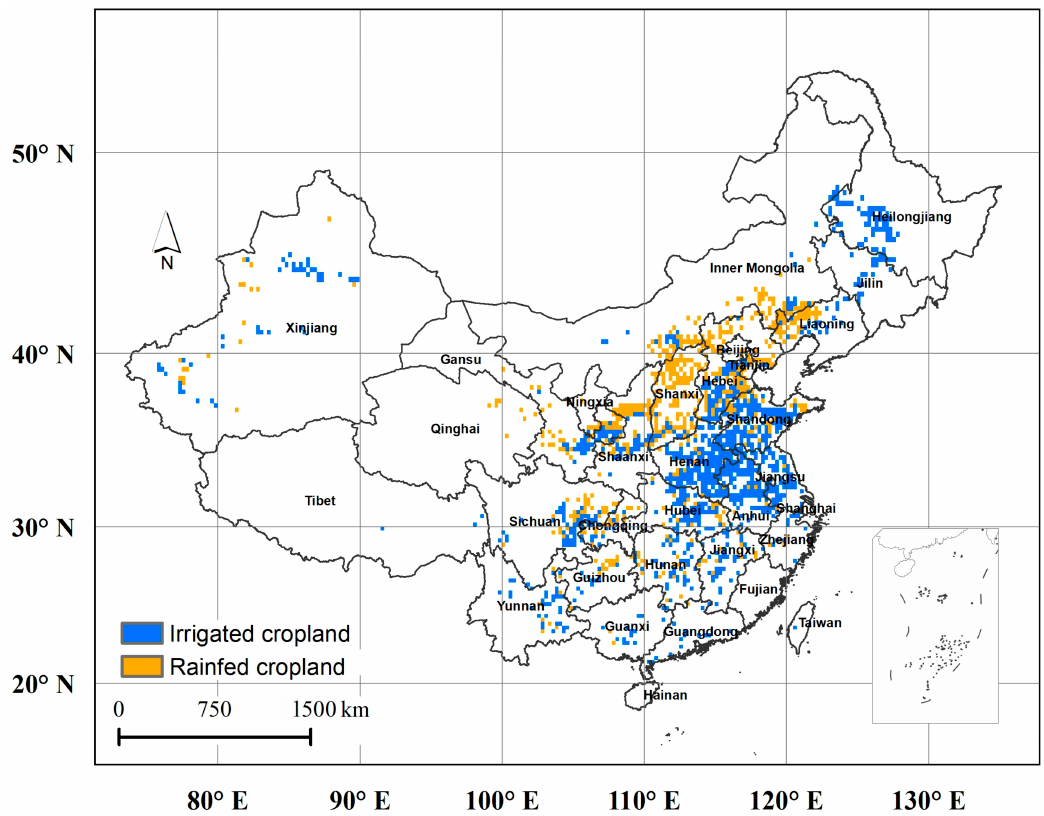
Figure 3. Actual irrigation area from the Irrigated Area Map Asia and Africa by International Water Management Institute (IWMI-IAMAA) circa 2010.